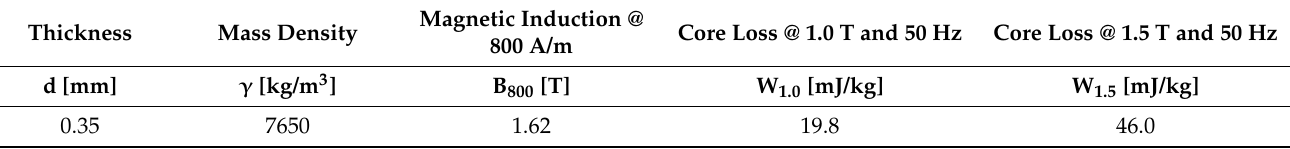
Table 1. Declared physical and geometrical properties of the 35H270 NGO steel.